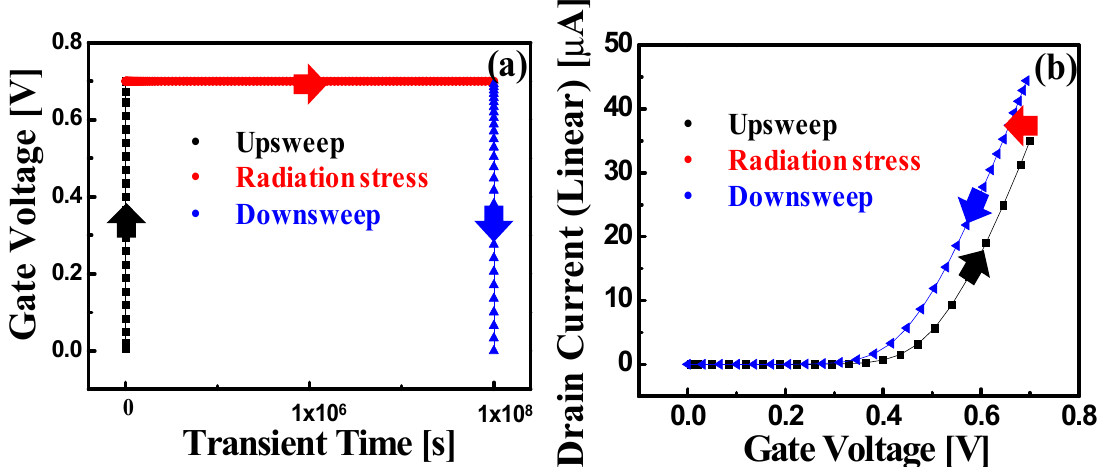
Figure 4. TID simulation method of the FinFET. ( a ) The V G -transient time; ( b ) the V T shift due to the interface trap.